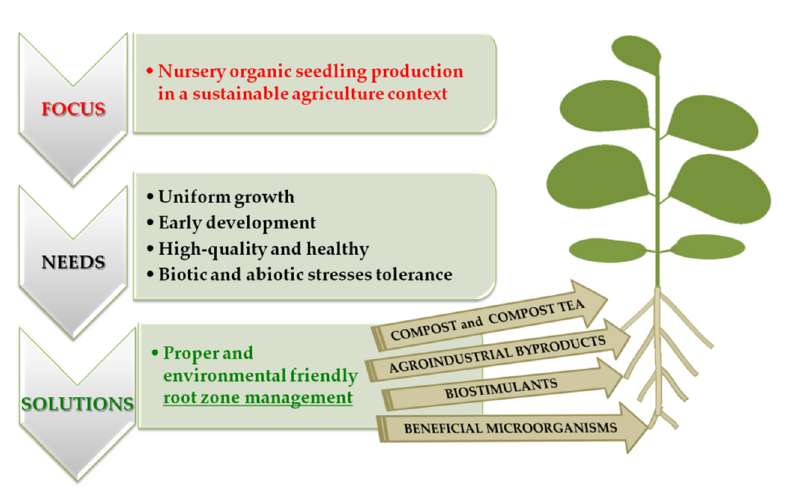
Figure 1. Root zone management for improving seedling quality of organically-produced horticultural crops.